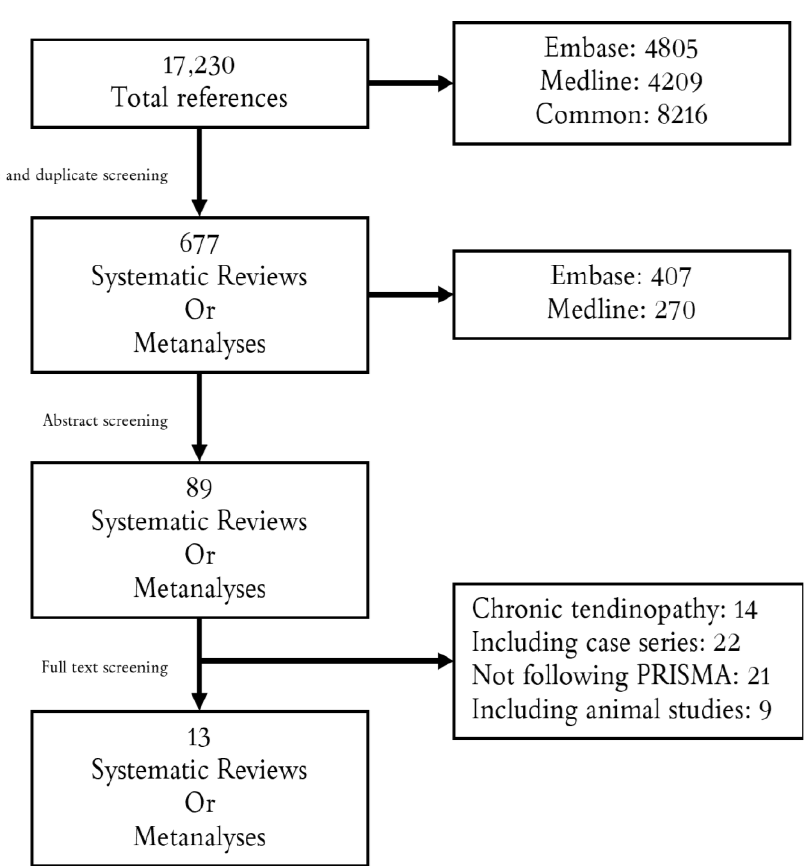
Figure 1. Flowchart of the selection process.